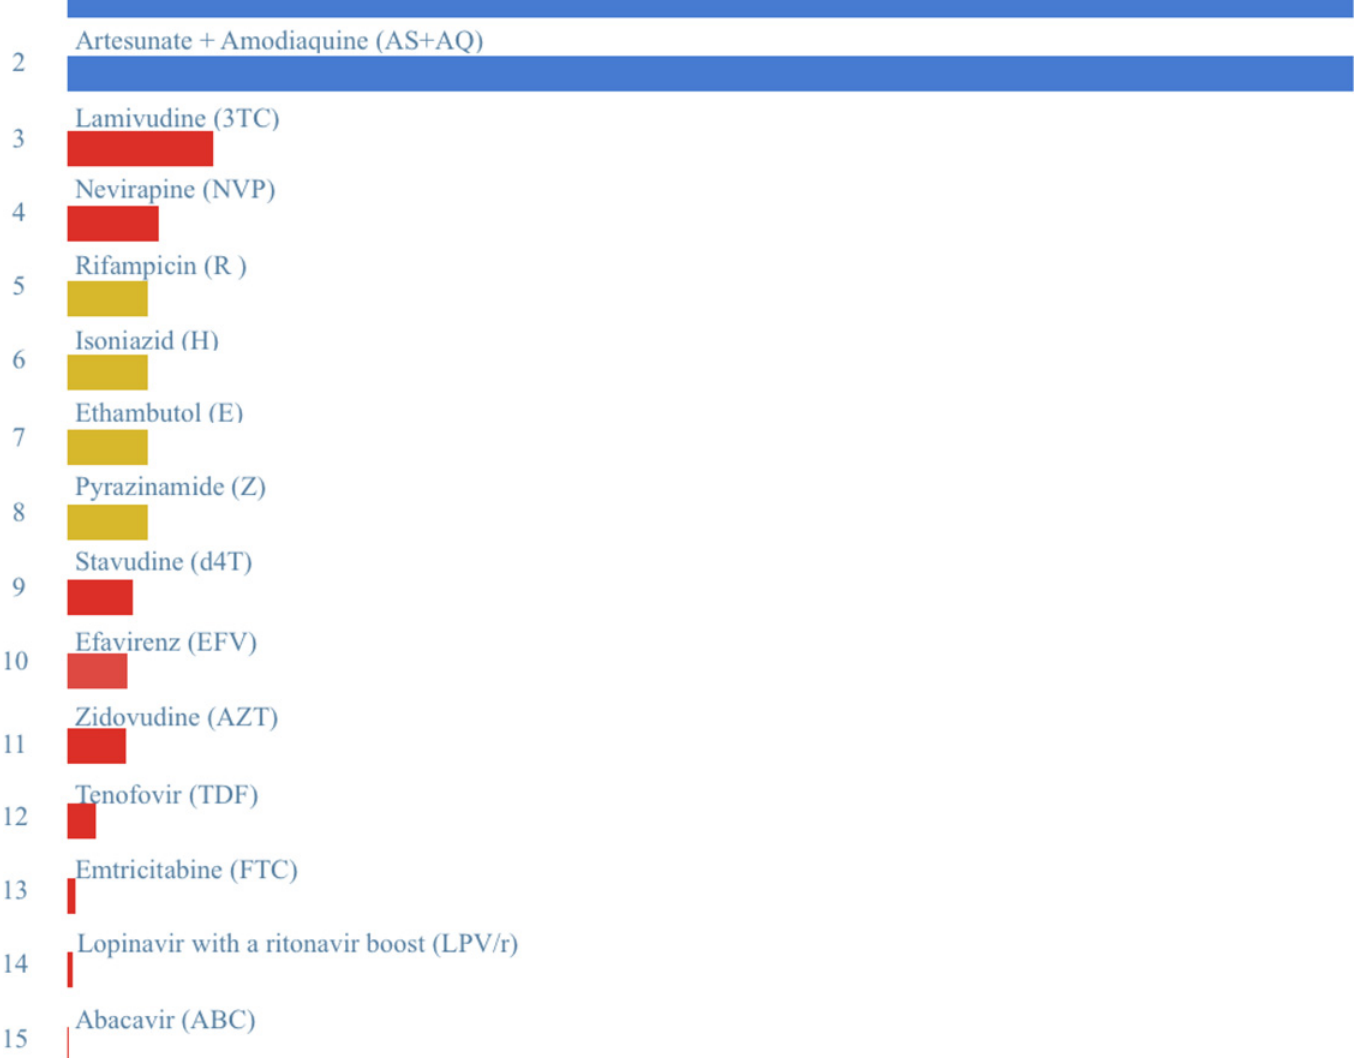
Fig 4. Impact scores of individual drugs by rank for Nigeria. A graph of the comparative impact of 15 drugs ranked from 1 (highest impact) to 15 (lowest impact) for the treatment of Malaria in Nigeria. Blue bars represent malaria drugs, yellow bars represent TB drugs, and red bars represent HIV drugs.